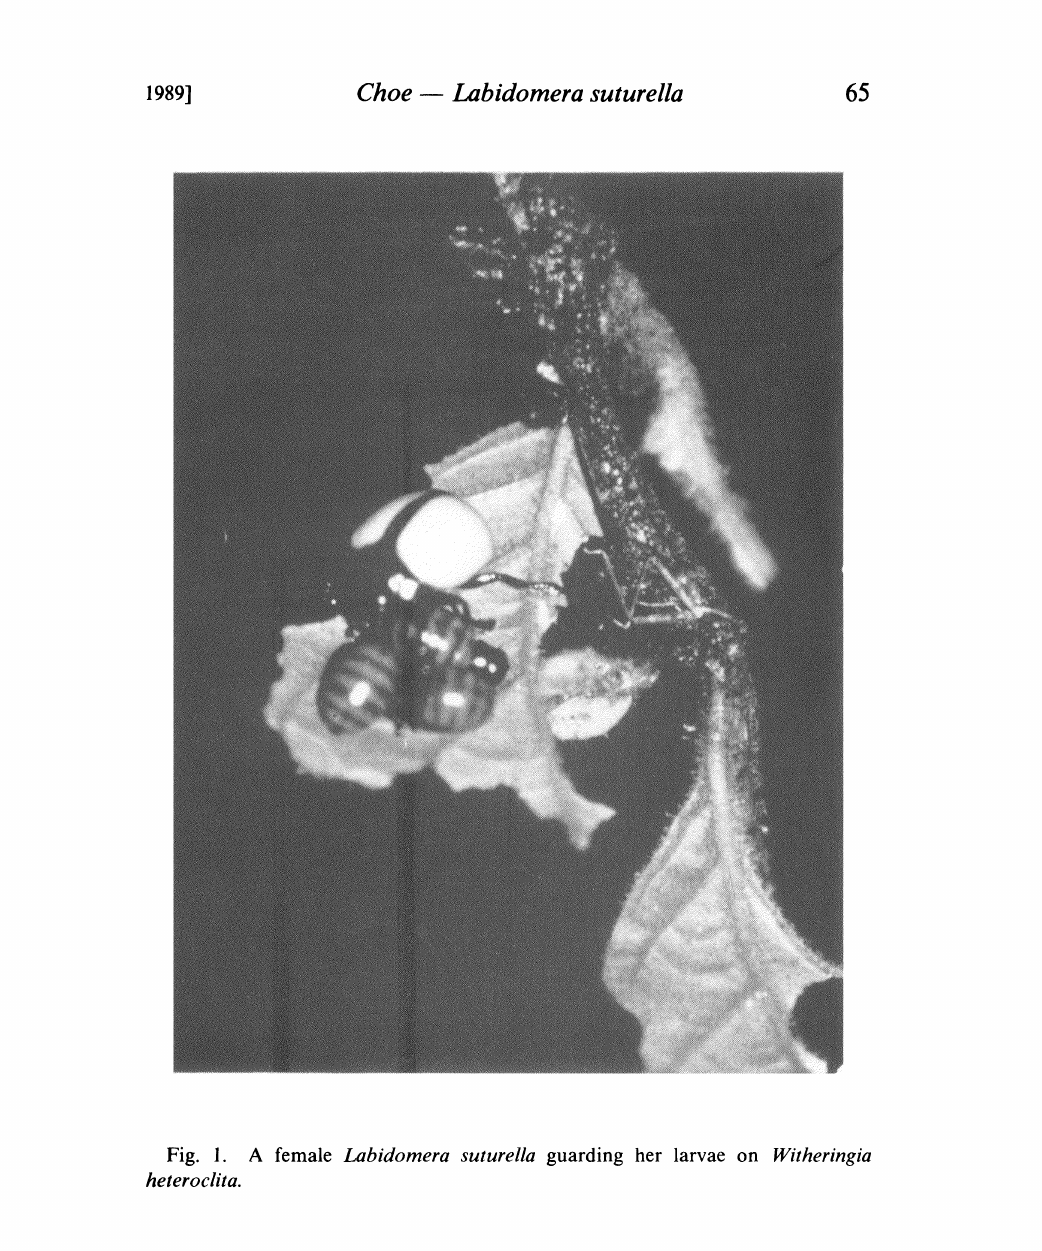
Fig. 1. A female Labidomera suturella guarding her larvae on Witheringia